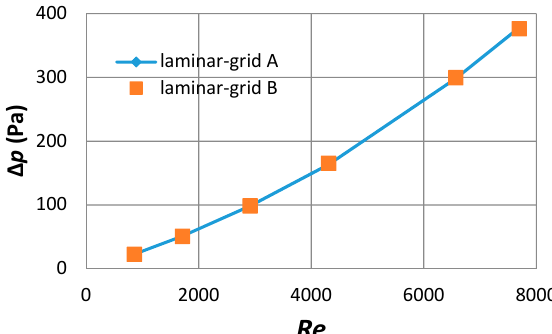
Figure 6. Comparison of the pressure drop against inlet Reynolds number, as predicted by the laminar flow simulations in grids A and B.